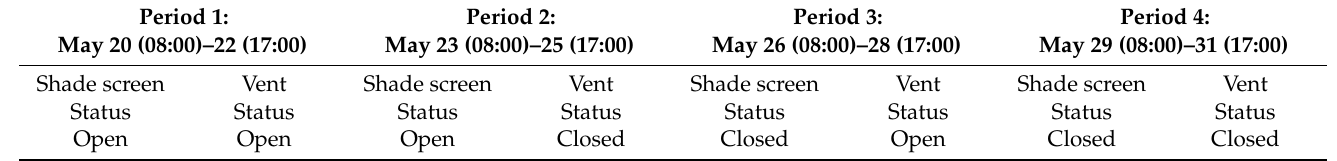
Table 1. Experimental periods—shade screen and vent status in each period in the greenhouse